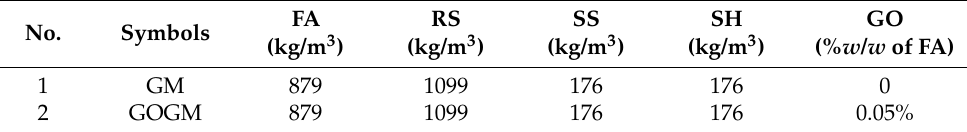
Figure 1. Specimen preparation ( a ) mold setup and ( b ) specimen after being demolded. Table 4. Mix proportion and compressive strength.